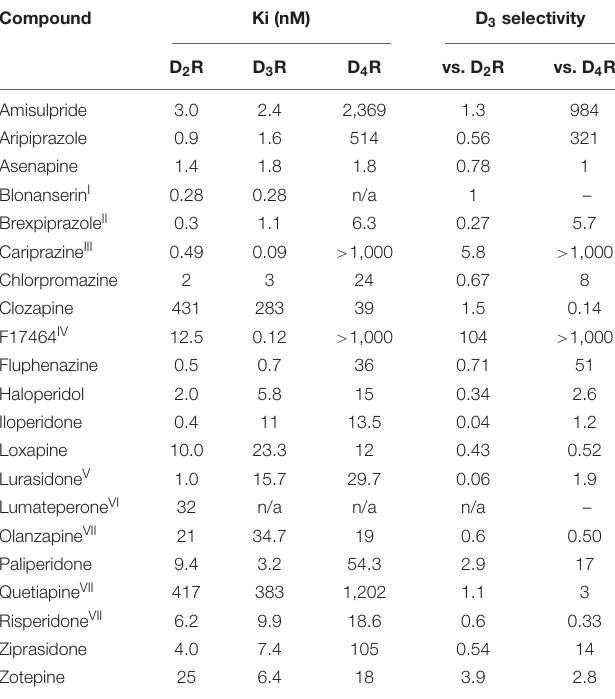
TABLE 1 | In vitro affinity of major first-, second-, and third-generation antipsychotics at human dopamine receptors of D 2 R-type and their degree of their D 3 R